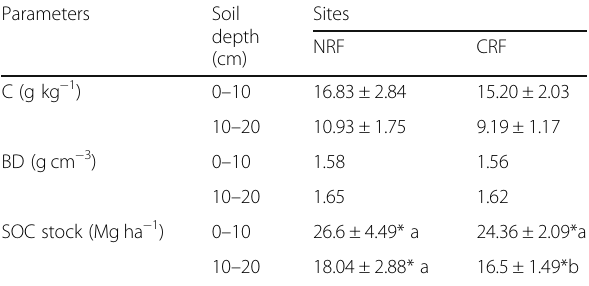
Table 5 Soil organic carbon content at different depths